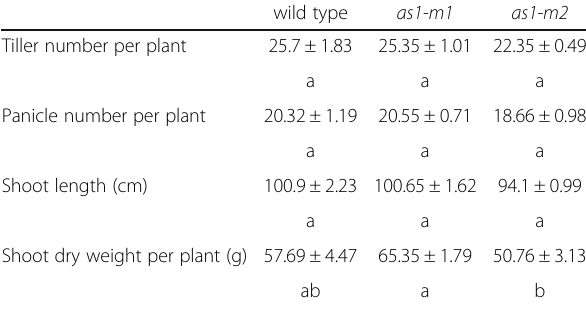
Table 1 Tiller number, panicle number and parameters of growth of plants growing in the paddy field Tiller number per